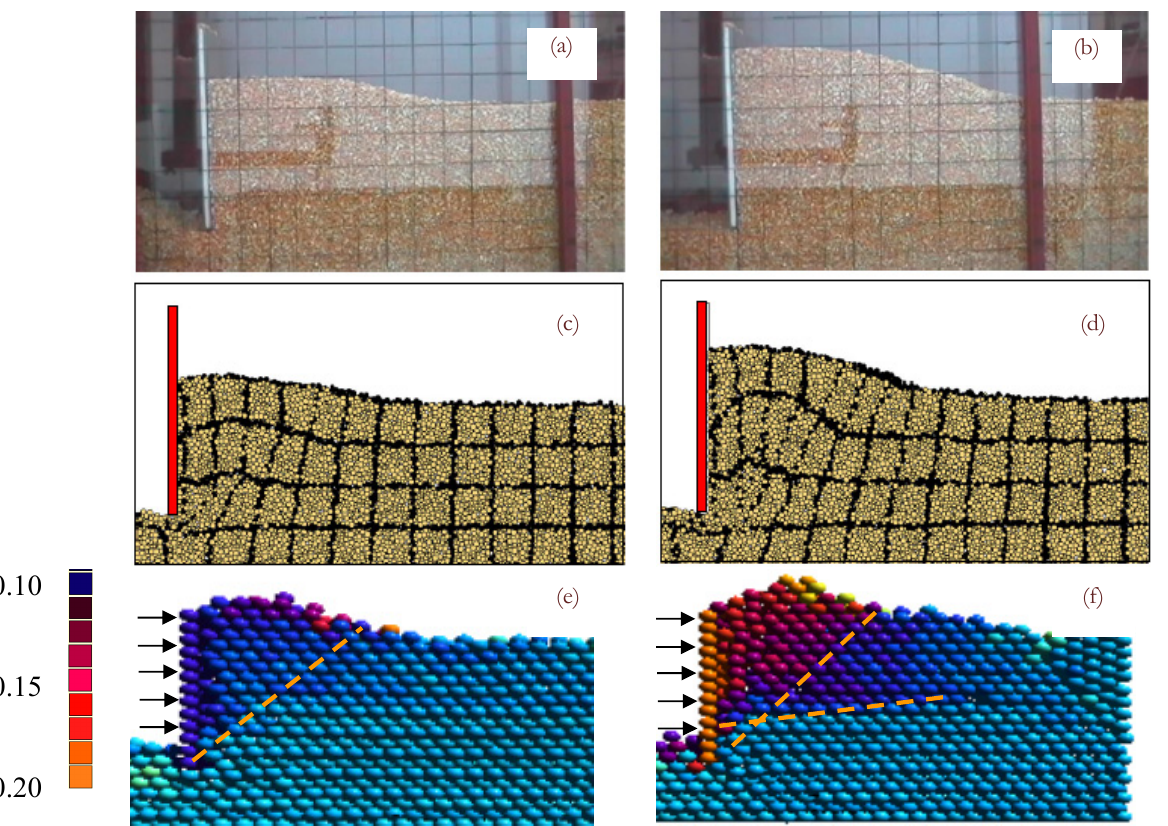
Figure 4: Configuration of particles for a blade displacement equal to: (a, c) 10cm, (b, d) 20cm [25], (e, f) corresponding configurations provided by the present model. Color scale indicates the horizontal displacement of the particles expressed in